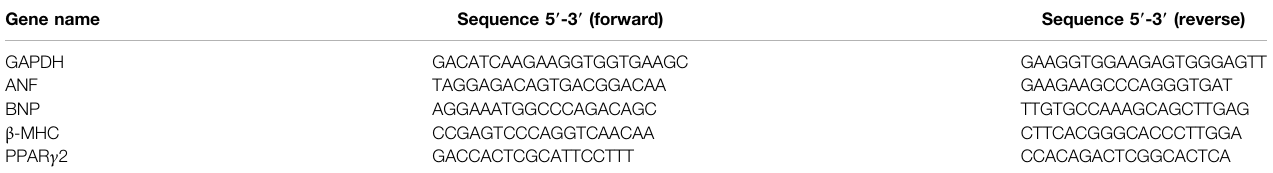
TABLE 1 | Primer information of quantitative real-time PCR experiments.